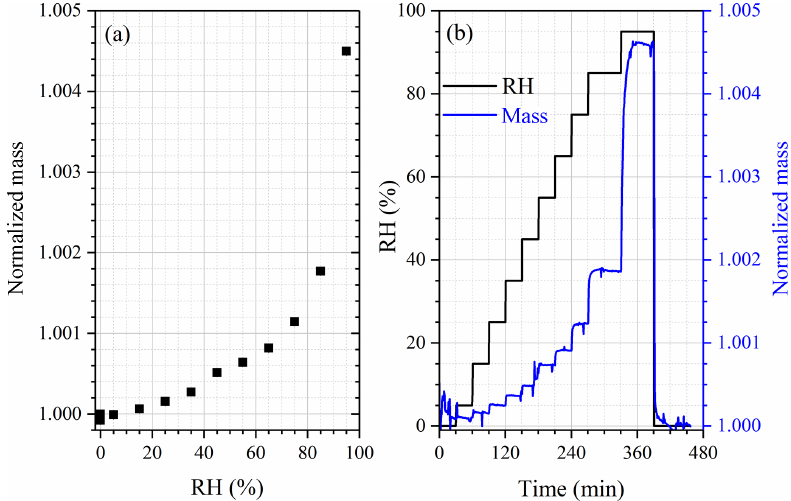
Figure 6. (a) Measured mass hygroscopic growth factors (normalized to the mass at 0% RH) of CaSO 4 · 2H 2 O as a function of RH up to 95% RH. Please note that error bars are included, but they are too small to be clearly visible. (b) Time series of RH and normalized mass of CaSO 4 · 2H 2 O particles with a dry mass of ∼ 9 . 05mg during a hygroscopic growth experiment. This experiment was carried out at 25 ◦